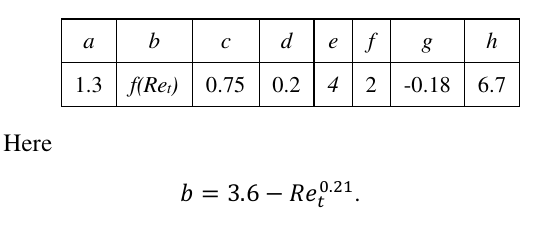
Table 2. Boundary layer parameters.